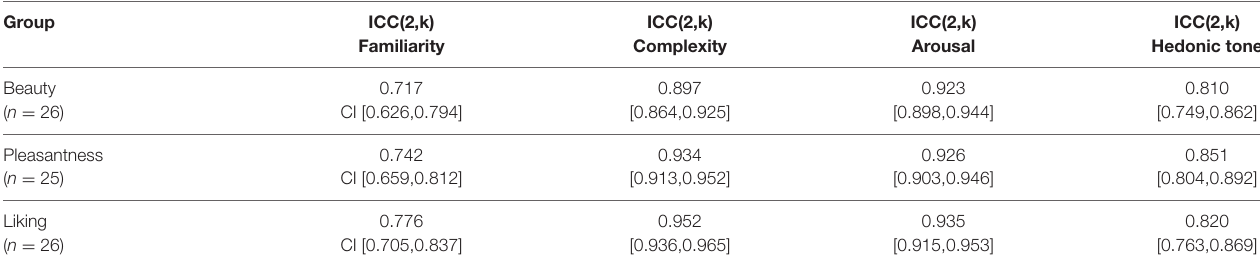
TABLE 7 | Intra-class correlation coefficients (ICCs) for subjective ratings of familiarity, complexity, arousal and hedonic tone (beauty, pleasantness and